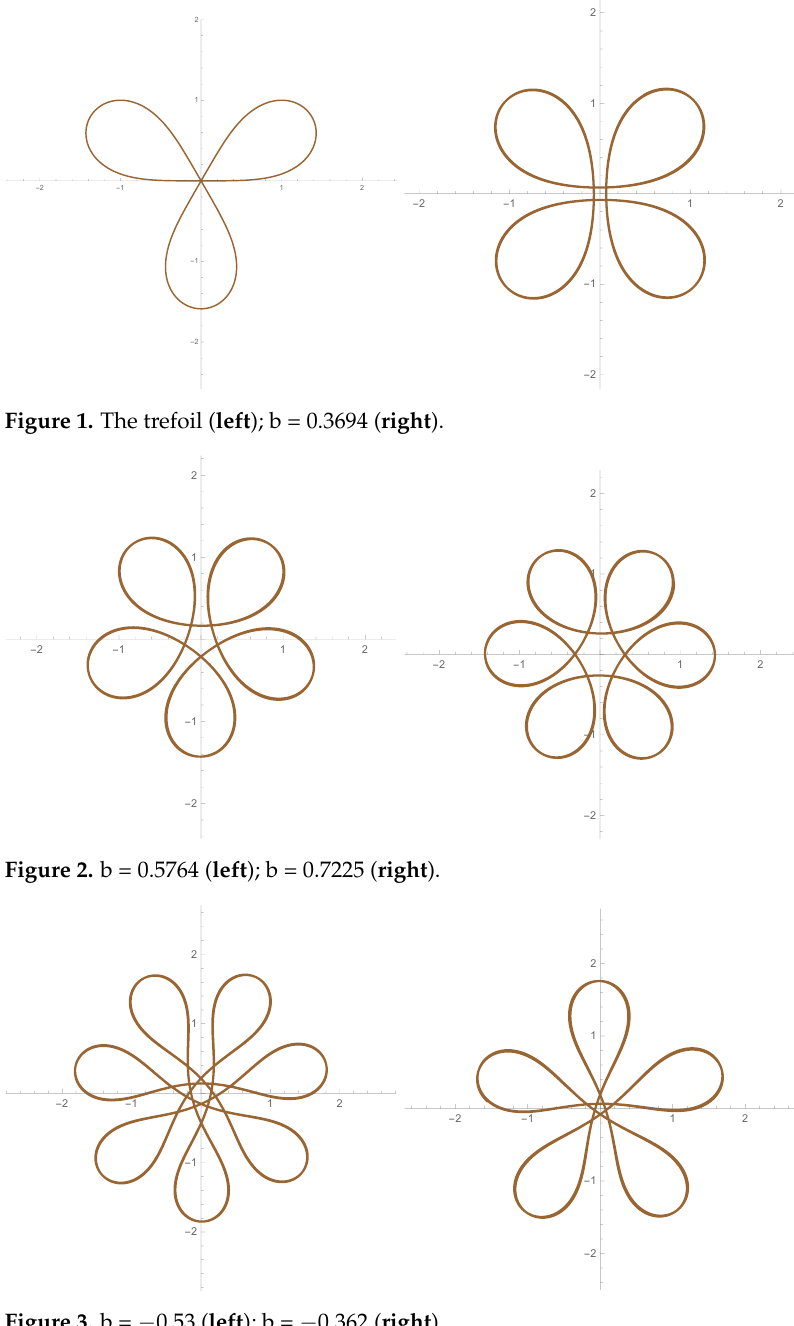
Figure 3. b = − 0.53 ( left ); b = − 0.362 ( right